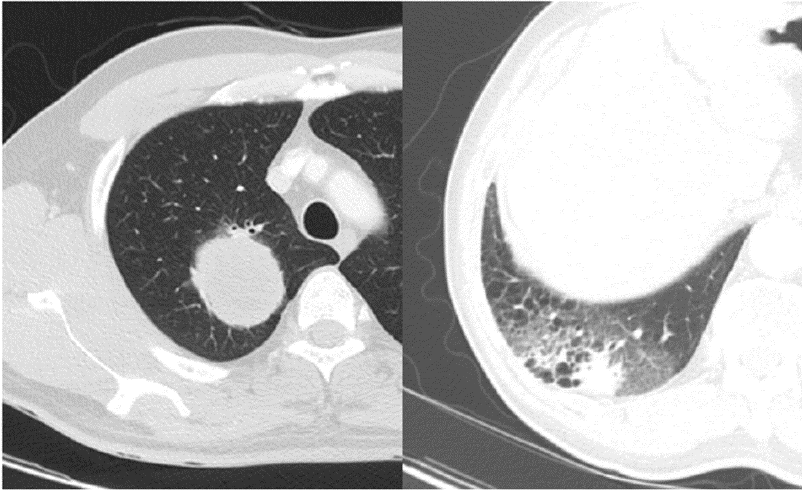
Figure 2. Comparison of lung adenocarcinoma with well-defined smooth margin (left) and ill-defined irregular margin (right).